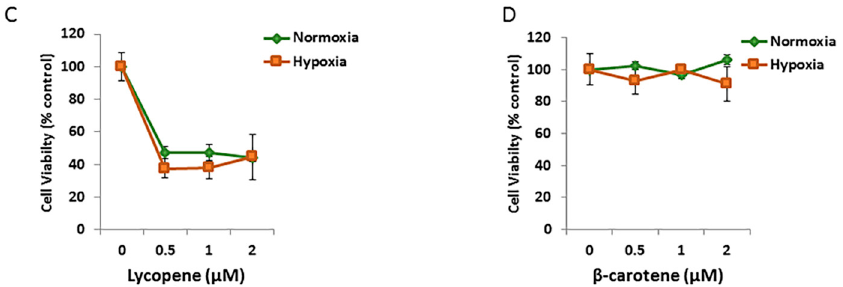
Figure 5. Effects of hypoxia and carotenoids on Retinal pigment epithelial (RPE) cell growth. ( A )